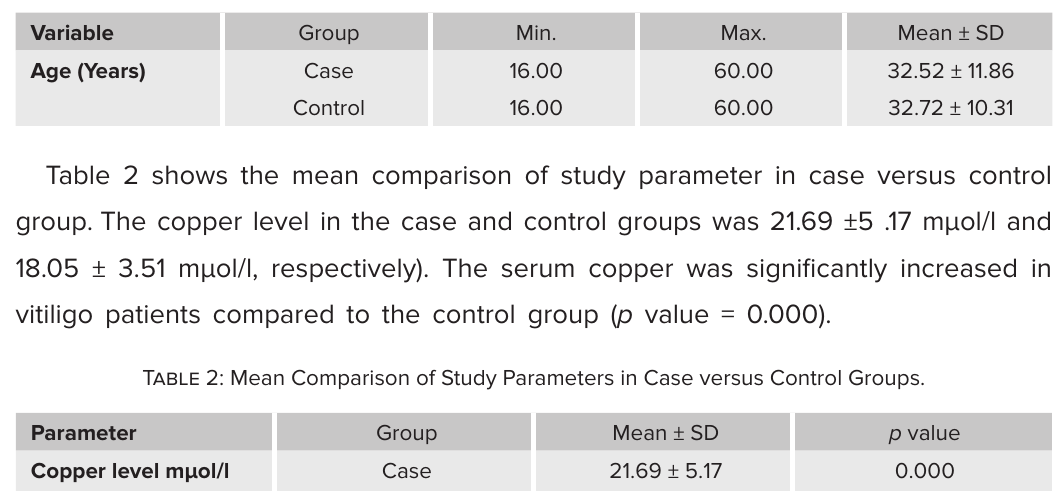
Table 1: Mean Comparison of Study Parameter Across Age.